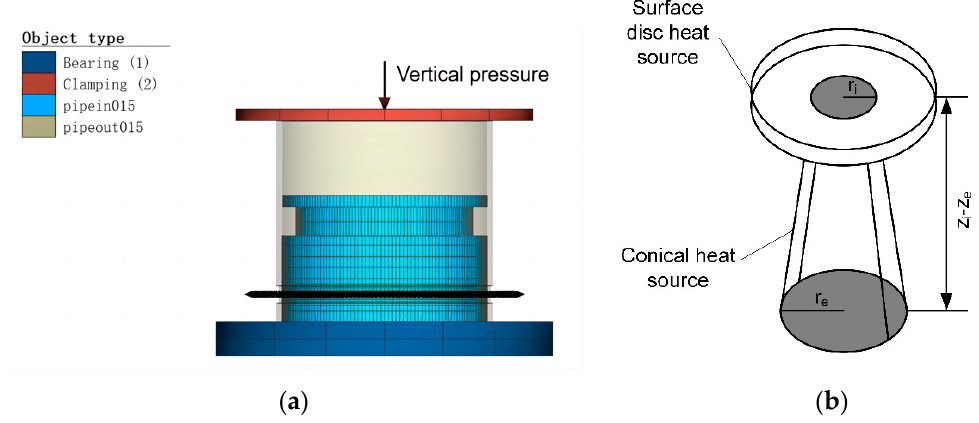
Figure 5. Grid model and laser heat source model: ( a ) Grid model; ( b ) laser heat source model.